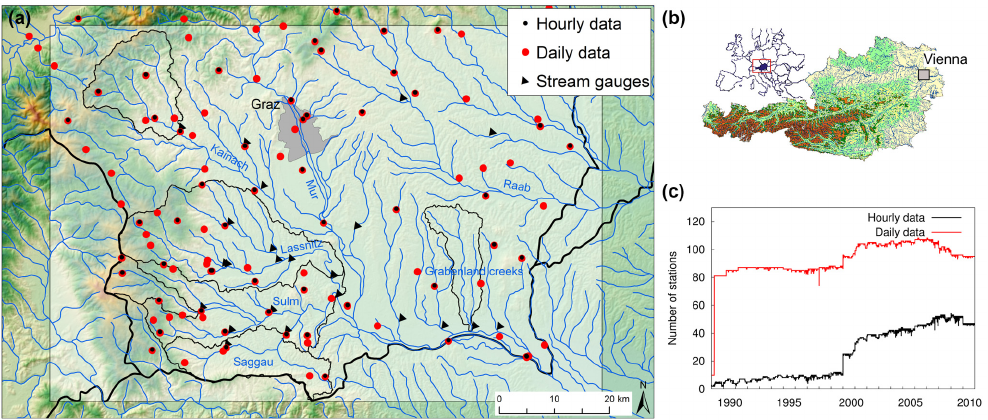
Figure 1. Study area and station distribution (a) as well as availability of high-resolution meteorological data (c) . Polygons are the catchment boundaries of the stream gauges for evaluation in this study (Table 1, Fig. 3).